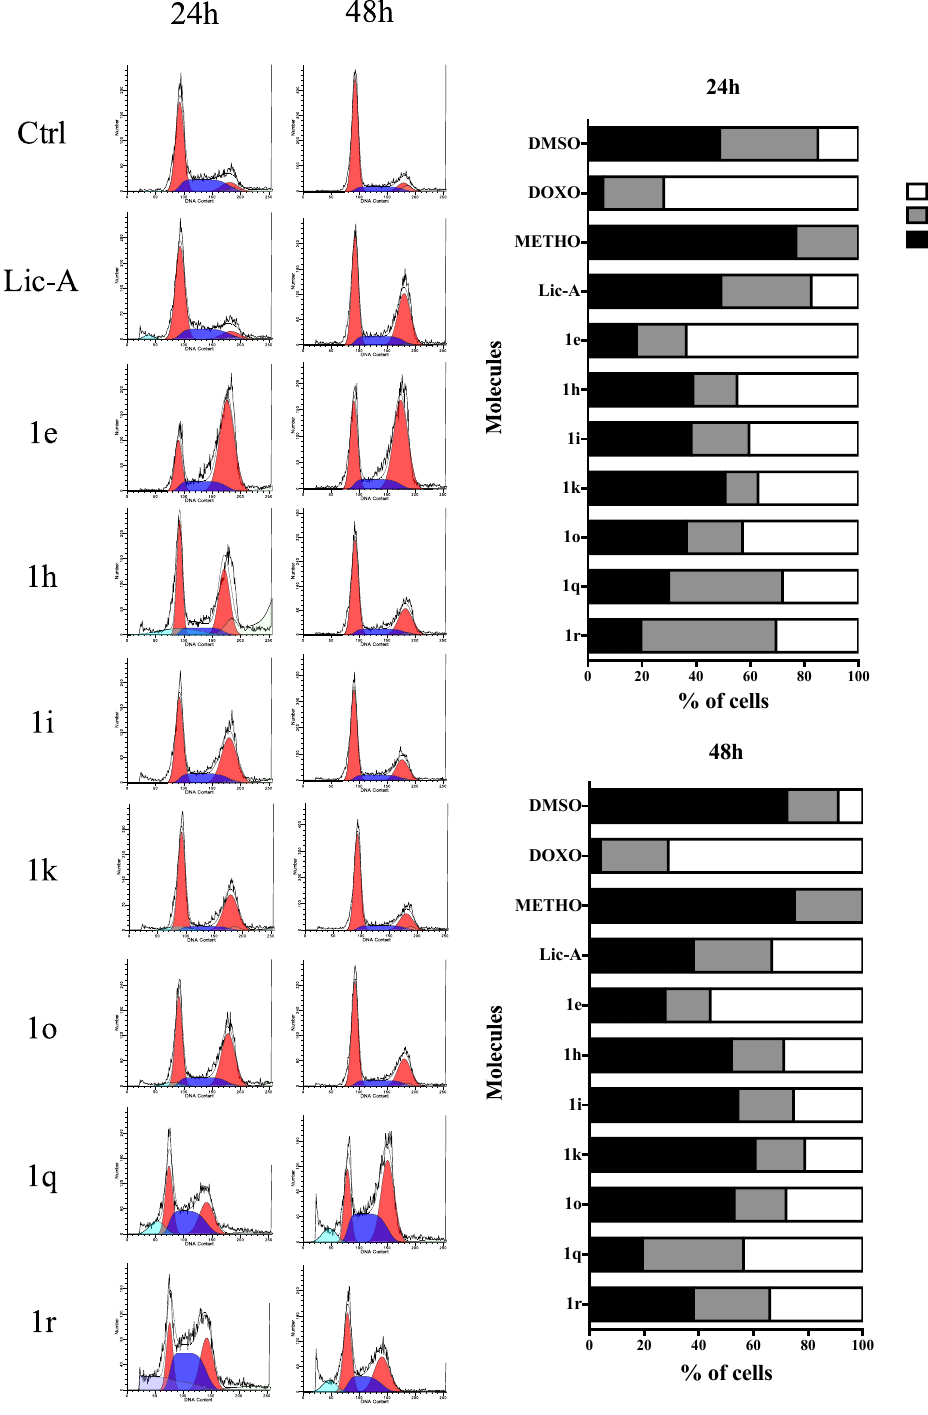
Figure 5. Cell cycle analyses. Cell cycle analyses were performed after 24 or 48 h of treatment